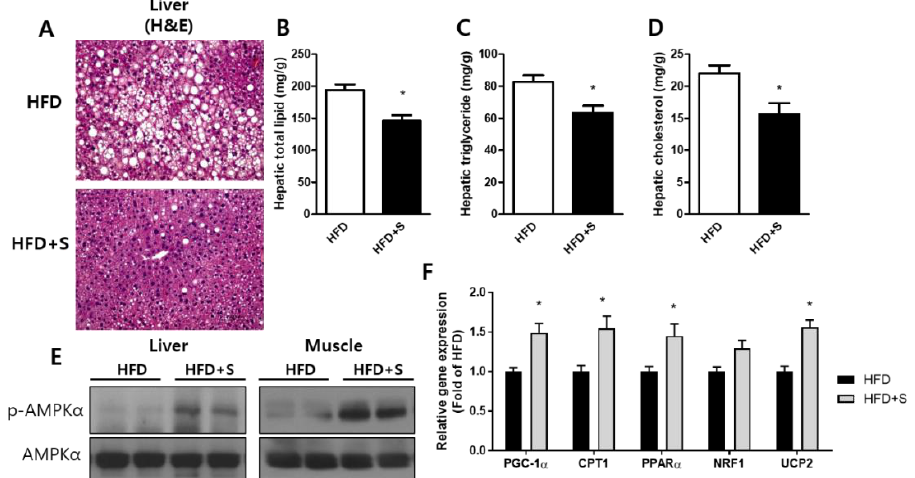
Figure 7. Shikonin ameliorates hepatic steatosis in HFD-induced obese mice. ( A ) Hepatic morphology changes were shown by hematoxylin and eosin (H&E) staining of liver sections. Original magnification, 200×. ( B – D ) Hepatic levels of total lipids, triglycerides, and total cholesterol were determined as described in the experimental section. ( E ) In liver and muscle total lysates, AMPK protein levels were determined by Western blot analysis. ( F ) In liver, relative mRNA expression levels of fatty acid oxidation and mitochondrial function related genes were measured by qRT-PCR. The results were expressed as mean ± SEM. *, p < 0.05.